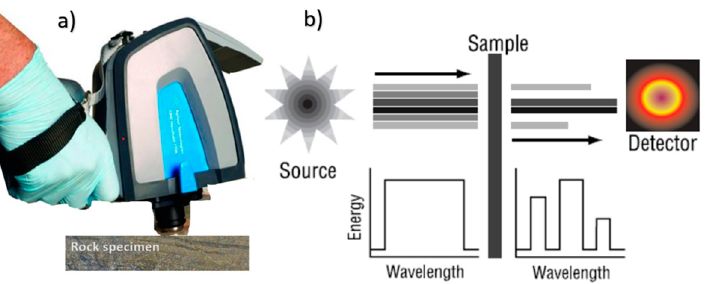
Figure 4. ( a ) Portable FTIR spectrometer, ( b ) a schematic diagram of a portable spectrometer, mod- ified from